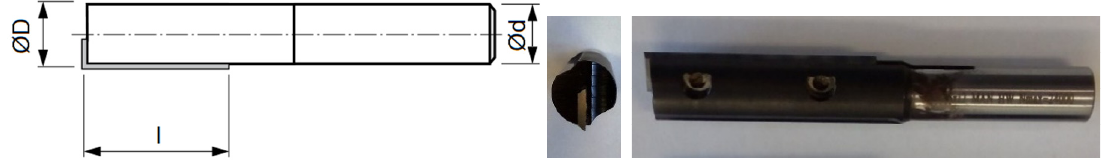
Figure 1. End mill used in the experiment-KARNED 4451 (ØD—working average, l—working length, Ød—clamping diameter).